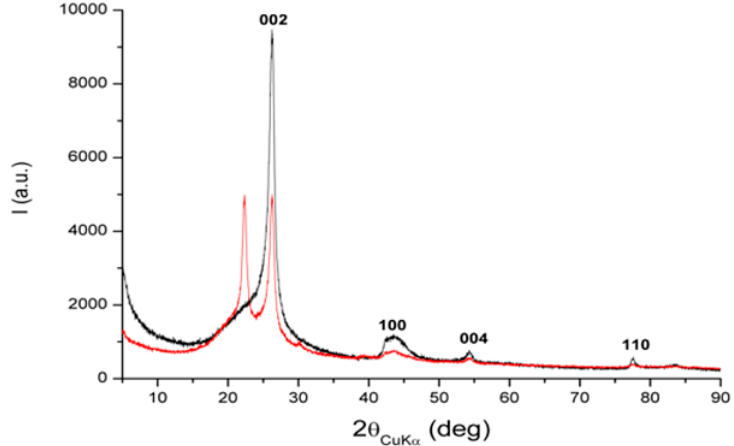
X-ray di ff raction patterns (Cu K α ) of graphite + pyrene-polybutadiene (black) and graphite + polybutadiene Figure 5. X-ray diffraction patterns (Cu K α ) of graphite+pyrene-polybutadiene (black) and graphite+polybutadiene (red).